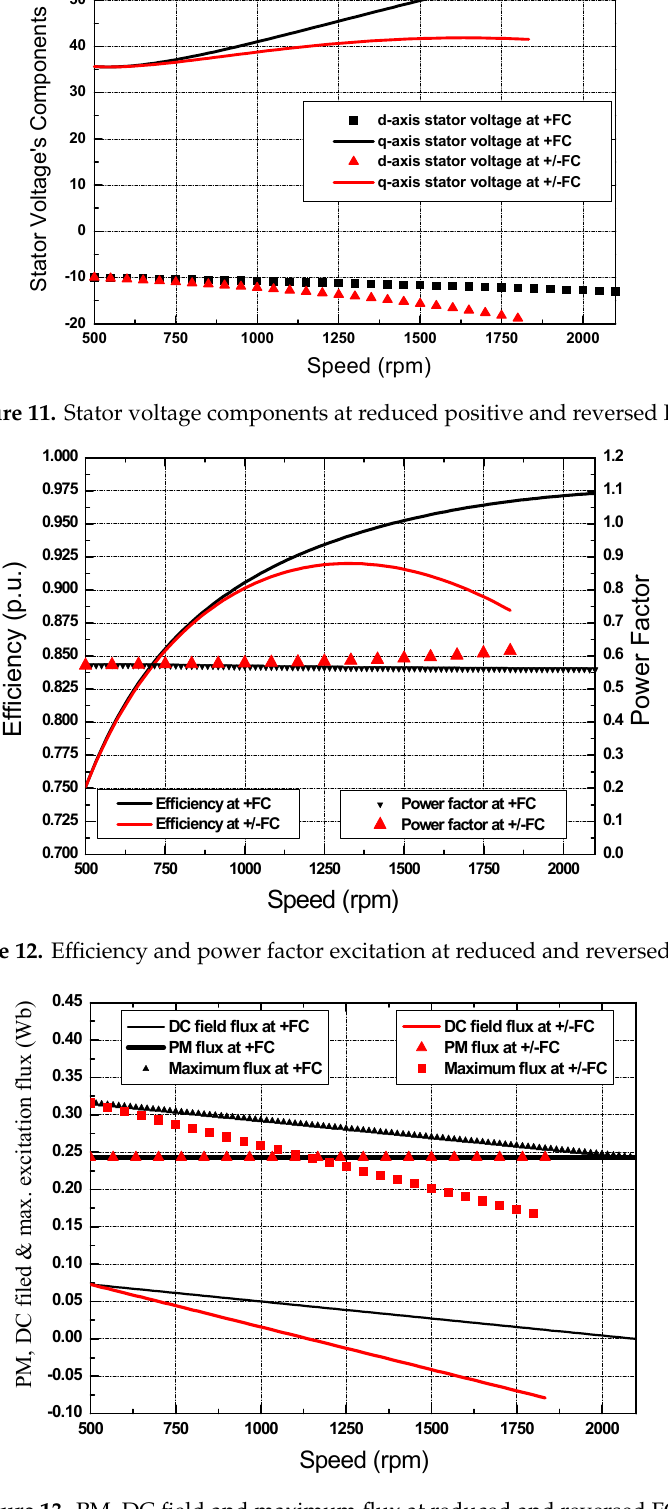
Figure 13. PM, DC field and maximum flux at reduced and reversed FC.